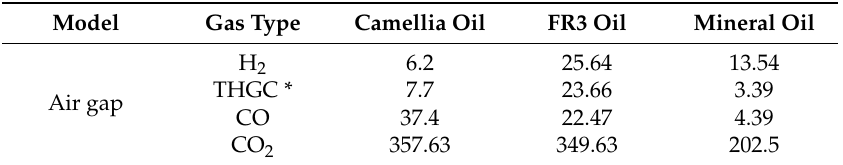
Table 7. Fault gas contents (in ppm) in oil under partial discharge.